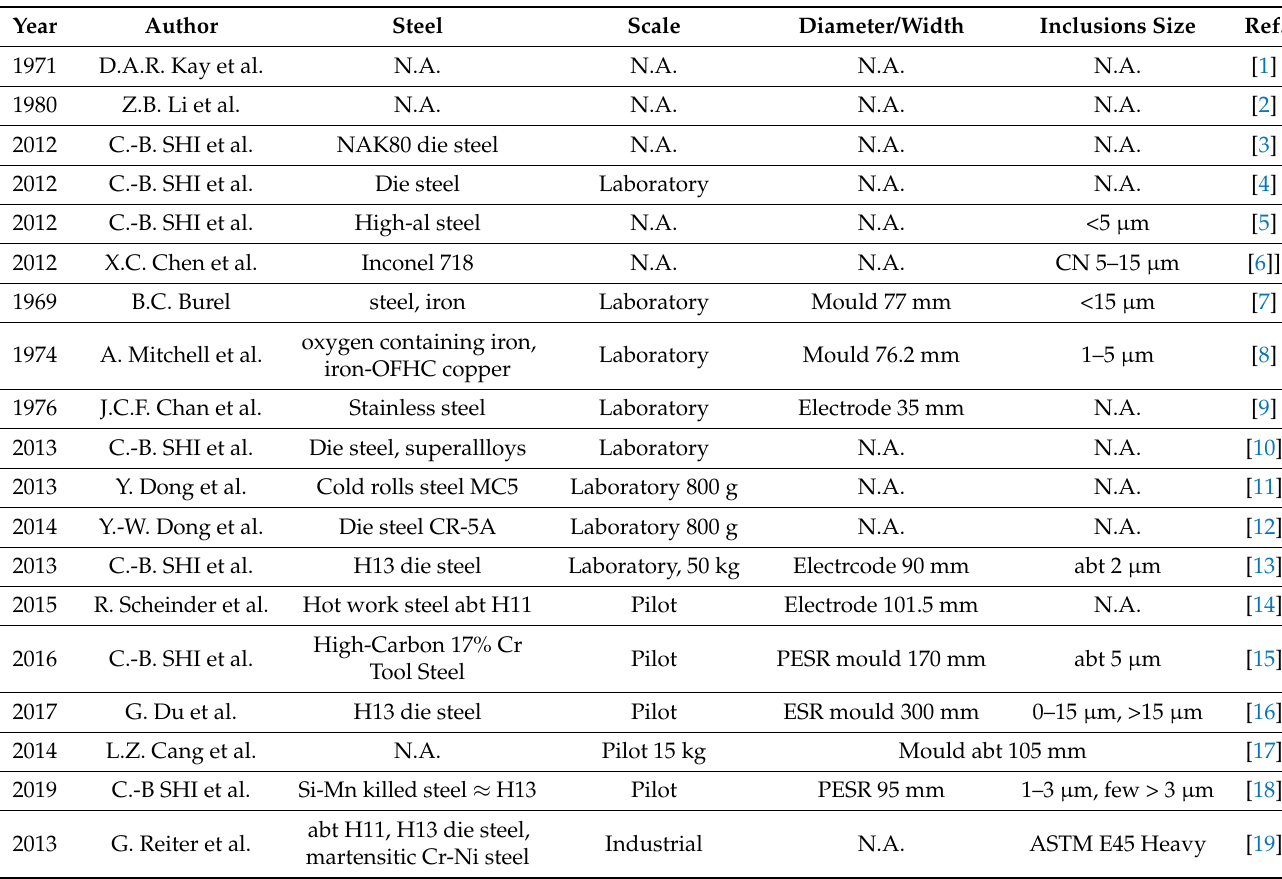
Table 1. Previous studies on inclusions in electro-slag remelting (ESR) or electro-slag remelting under protective pressure- controlled atmosphere (PESR)